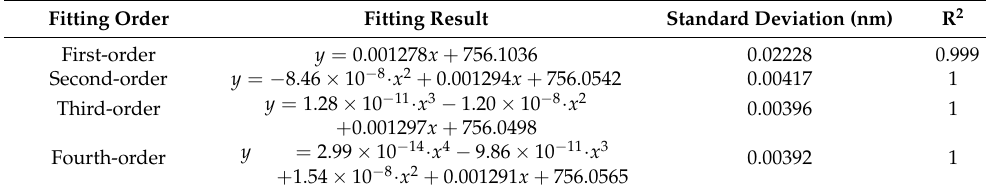
Table 9. Fitting results of the corresponding relationship between the center wavelength of the molecular oxygen A-band observation channel (channel 2) and the PBSC.